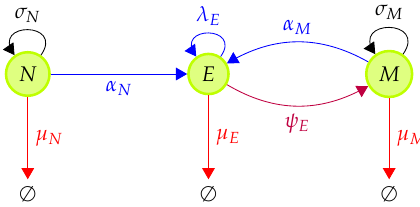
Figure 9. Differentiation pathway during a T cell immune response to a viral infection. During a viral infection we have the following events: (i) Naive cells, N , differentiate into effector cells with rate α N when presented with VDPs they recognize. (ii) Effector cells, E , proliferate with rate λ E . (iii) Memory cells, M , differentiate into effector cells with rate α M when presented with VDPs they recognize. Naive cells are homeostatically maintained by survival stimuli from self-pMHCs with rate σ N . Memory cells are homeostatically maintained by survival stimuli from cytokines with rate σ M . Naive, effector and memory cells die at (per cell) rates µ N , µ E and µ M , respectively. Once infection is cleared, effector cells differentiate into memory cells at a rate ψ E . We assume ψ E is such that ψ E = β , with β a fraction in the range of 5–10 % ψ E + µ E